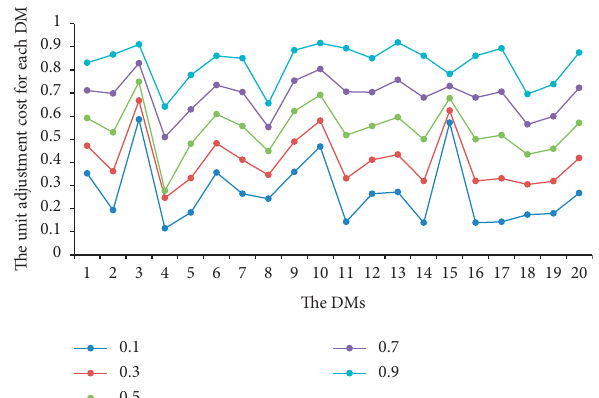
Figure 3: .e unit adjustment cost with different ϑ for each